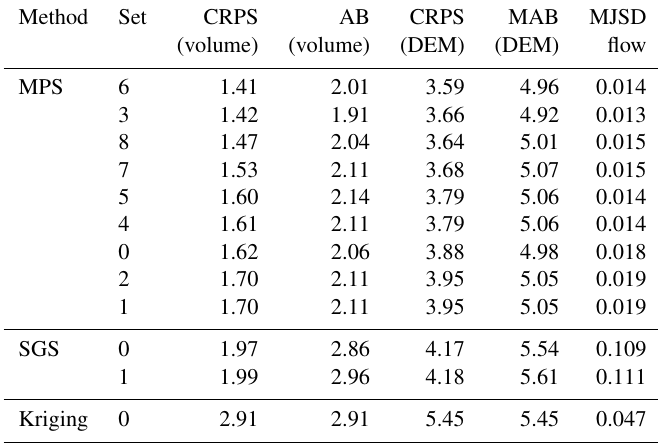
Table 2. Quality indicators averaged over all realizations for different simulation methods (MPS, SGS, kriging) and for different parameter sets. The rows are sorted by best (lowest) CRPS score of ice volume estimation. CRPS score of ice volume estimation, mean absolute error of the ice volume, CRPS score of DEM averaged over all points, mean absolute error of DEM averaged over all points, and Jensen–Shannon divergence of flow accumulation distributions averaged over all